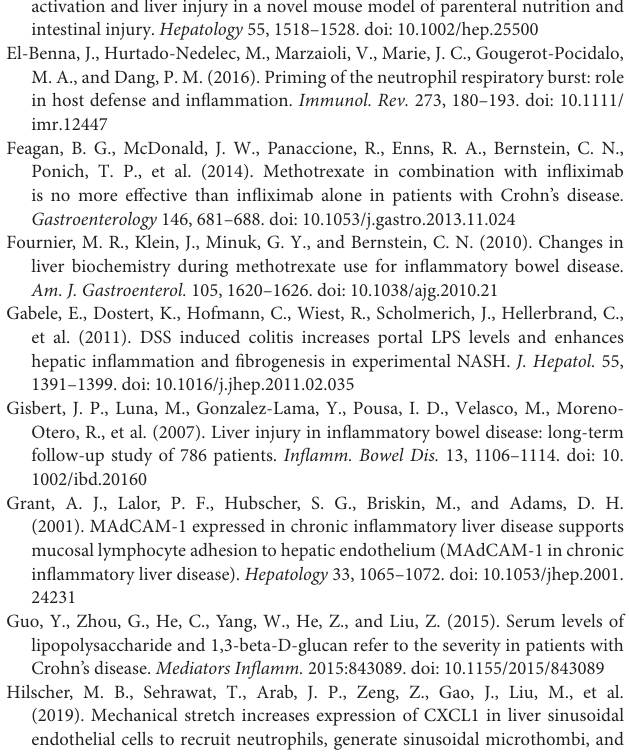
Supplementary Table 2 | Disease activity index